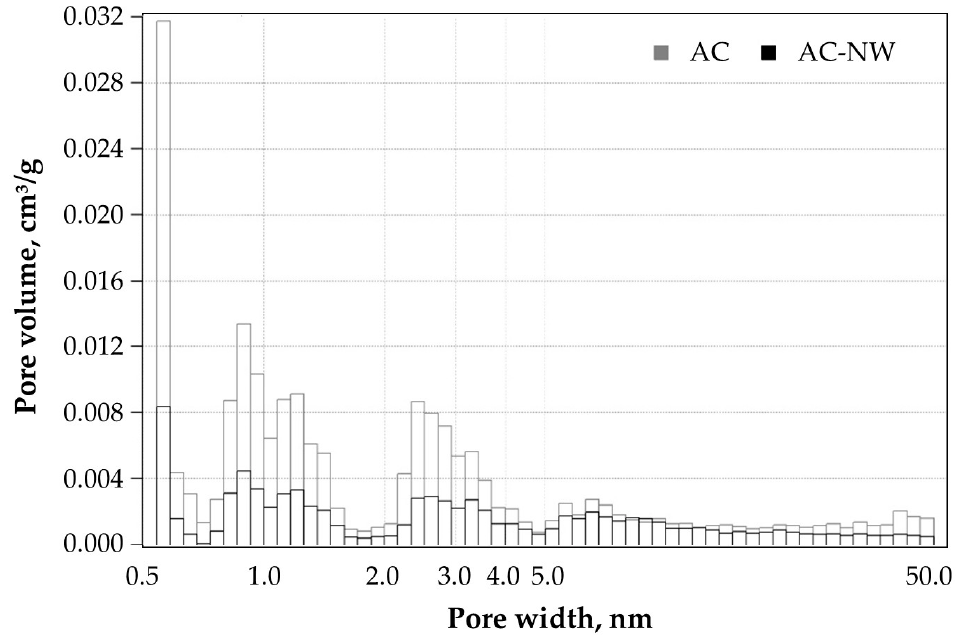
Figure 5. Pore size distribution of AC and AC-NW composite based on QSDFT model.